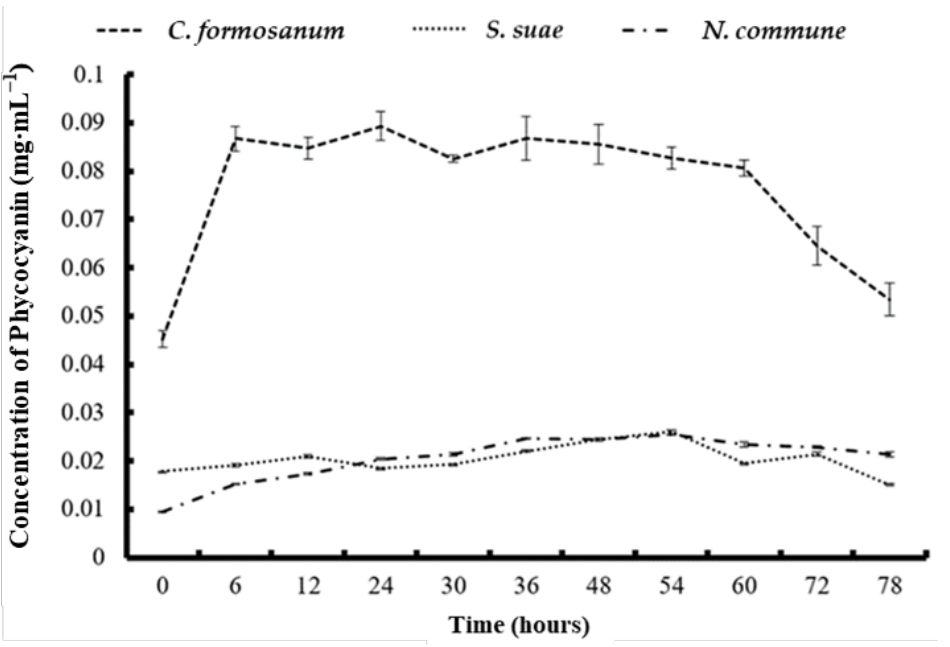
Figure 2. The concentration of phycocyanin in Colaconema formosanum , Sarcodia suae , and Nostoc commune as substrates fermented with Pseudoalteromonas haloplanktis , ATCC 14393. The APC concentration increased slightly between the start of fermentation and 36 h, and the highest APC concentration (0.096 mg mL −1 ) was obtained at 36 h. After 36 h, the APC concentration decreased slightly (Figure 3). The Chl a concentration gradually rose until 72 h, when it reached its highest concentration (22.12 mg mL −1 ; Figure 4).